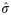
Ca2+ spike rate estimation.Spike rate estimations for data shown in Fig 4B for 1 (A), 2 (B), 4 (C) and 7 (D) randomly chosen Ca2+ spike sequences (black dots) using KS with σ = 35 (grey), 52 (orange), 70 (purple), and σ^ (blue). The black line denotes results from a GP(black). The dotted red line indicates the original Ca2+ spike rate. The light blue areas delineate the 95% GP estimation confidence interval.